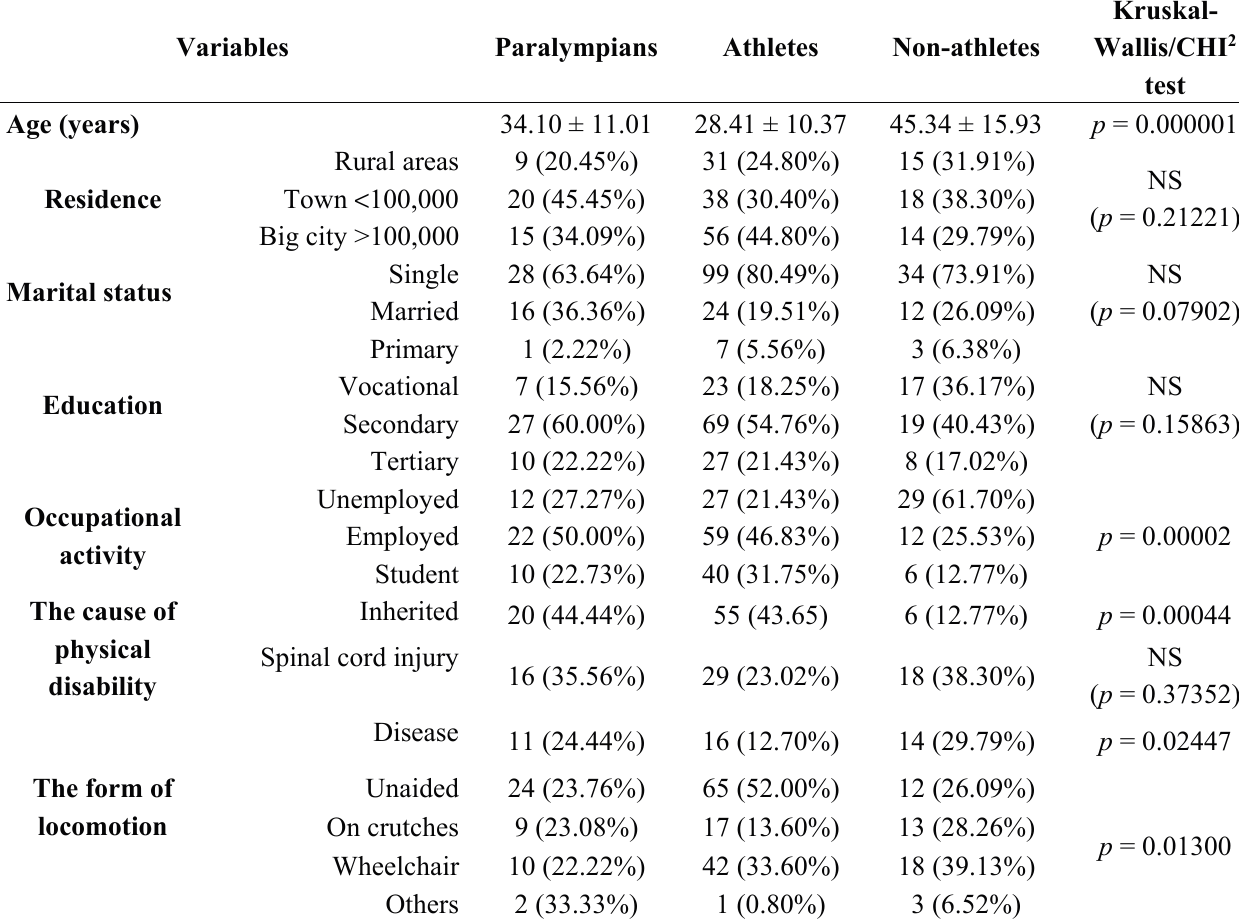
Table 1. Socio-demographic characteristics of the study population (mean ± SD / n